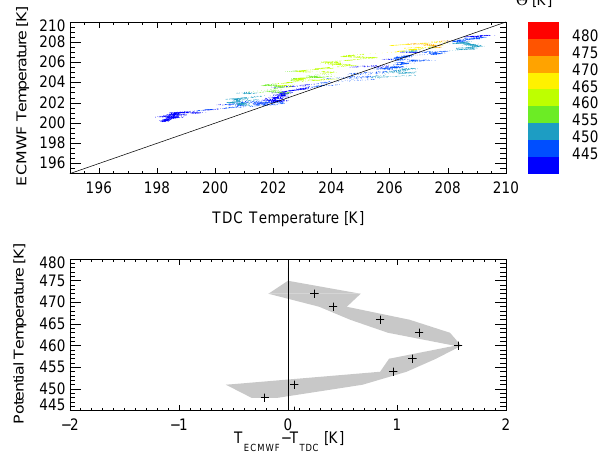
Fig. 2. Top: Temperatures interpolated from ERA-INTERIM data on the flightpath versus TDC temperature measurements on board the Geophysica as function of potential temperature for the flight on 7 March 2005. Bottom: Vertical profile of temperature differences averaged into 3 K